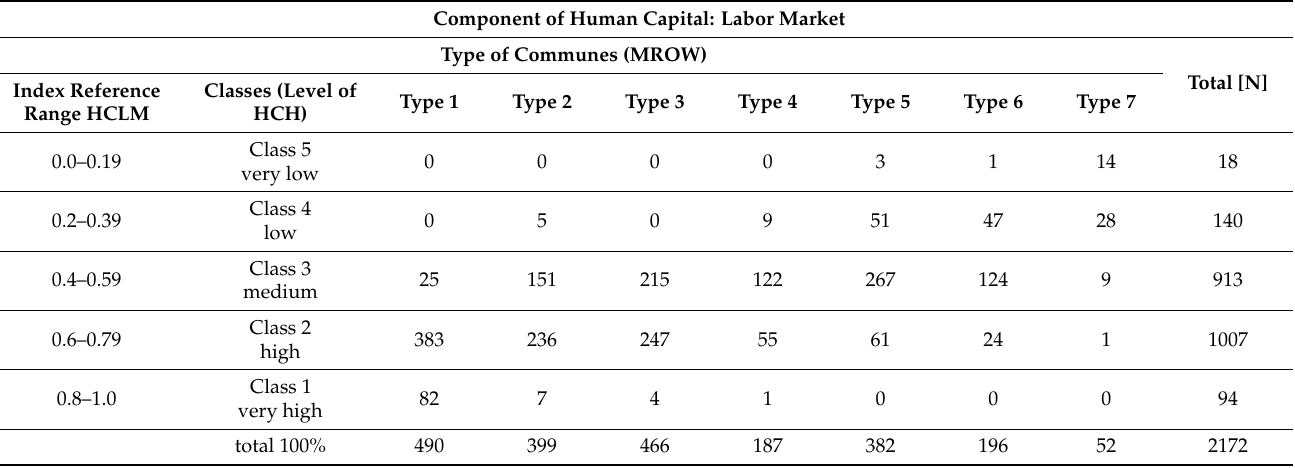
Table 10. The level of human capital in area of labor market [HCLM] vs. rural areas by MROW. Component of Human Capital: Labor Market Type of Communes